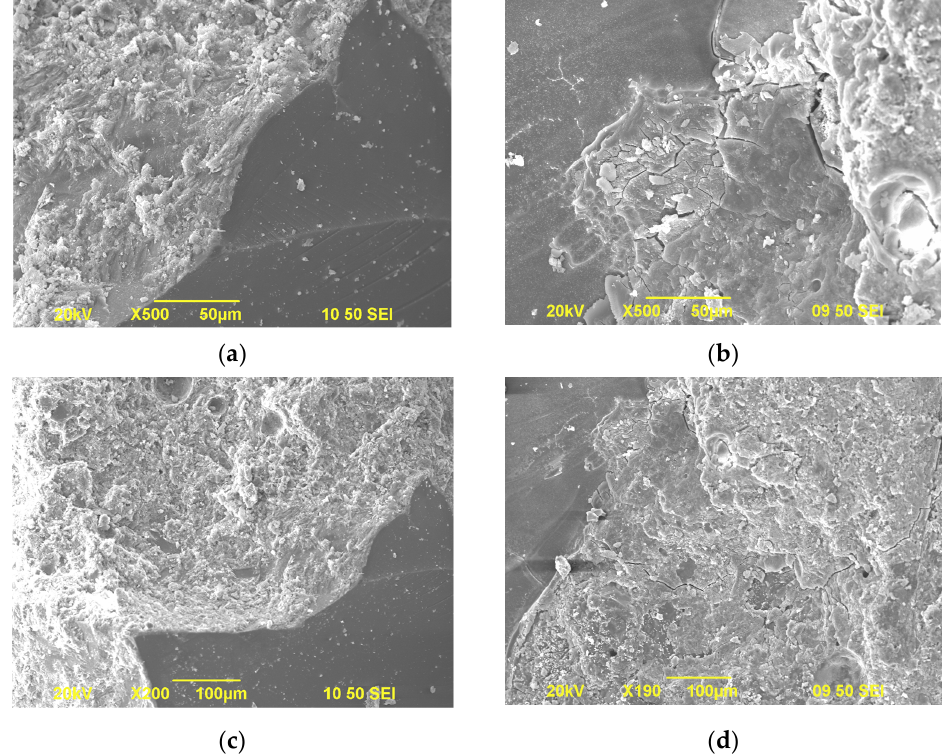
Figure 8. SEM images of Control 0.41 under the 7-day water curing at 80 °C ( a , c ) and the 7-day alkali curing at 80 °C ( b , d ).